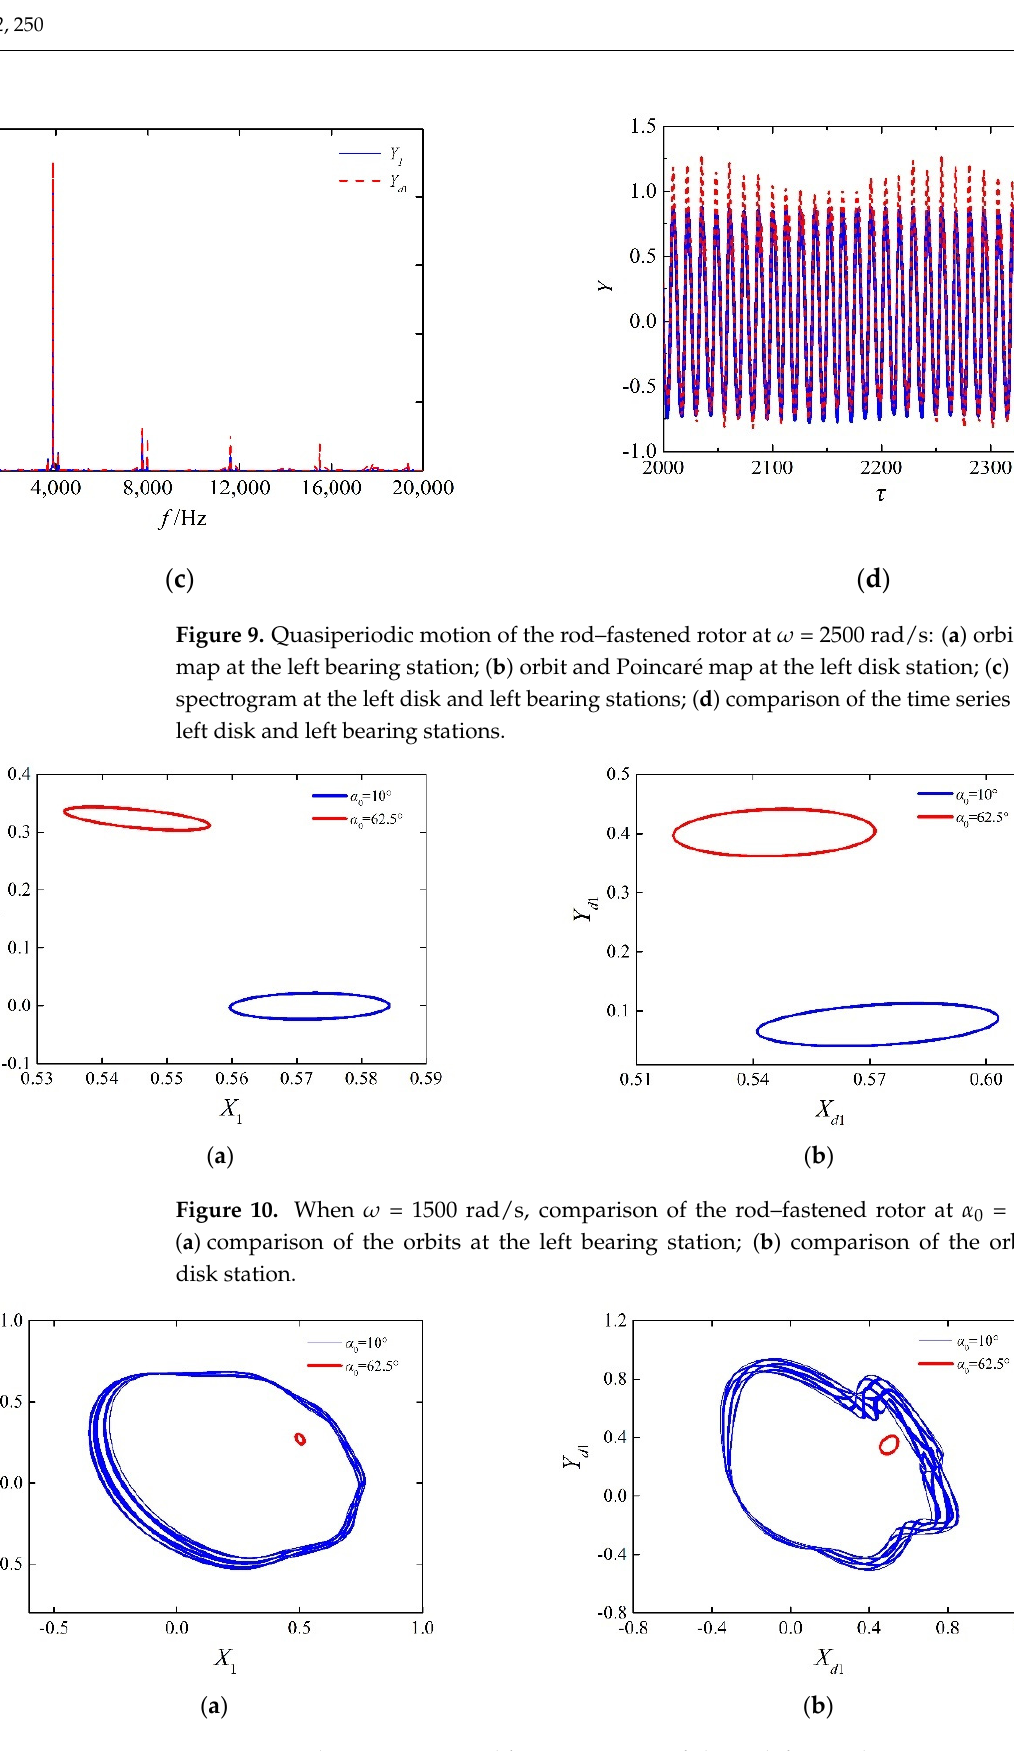
Figure 11. When ω = 2000 rad/s, comparison of the rod–fastened rotor at α 0 = 10° and 62.5°: ( a ) comparison of the orbits at the left bearing station; ( b ) comparison of the orbits at the left disk station.